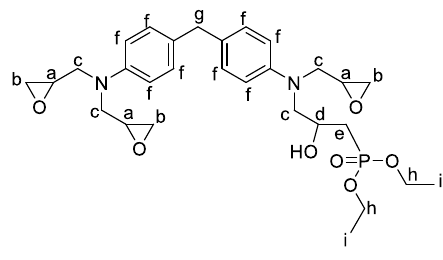
Figure 12. MBDA-DEP structure. Figure 12. MBDA-DEP